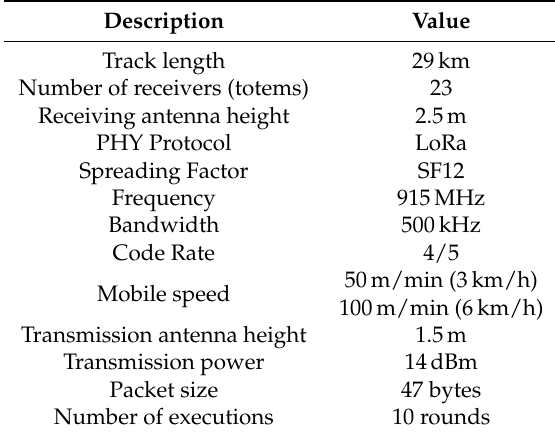
Table 3. Simulation parameters in